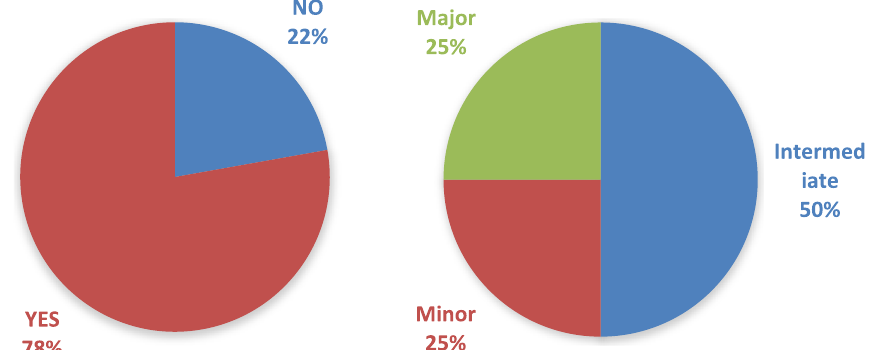
Fig. 9 Discrepancies between the estimated project duration and final project duration achieved. Ref: